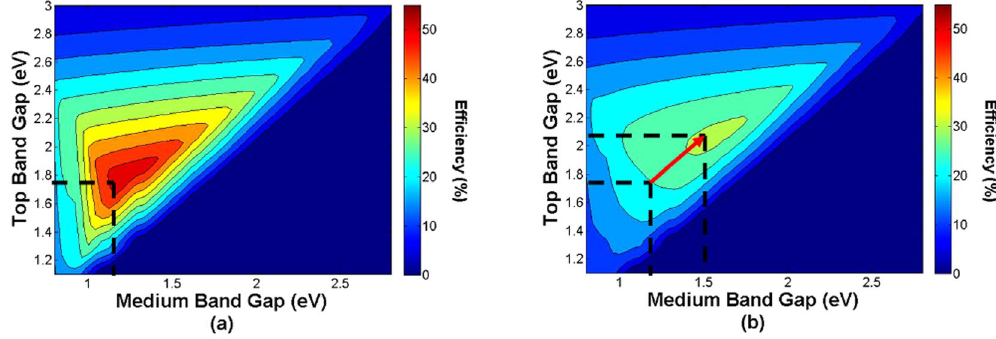
Figure 1. Iso-efficiency curves of 3-J cells under 2500 suns for different lumped series resistance values: ( a ) 0.01 Ω cm 2 and ( b ) 0.05 Ω cm 2